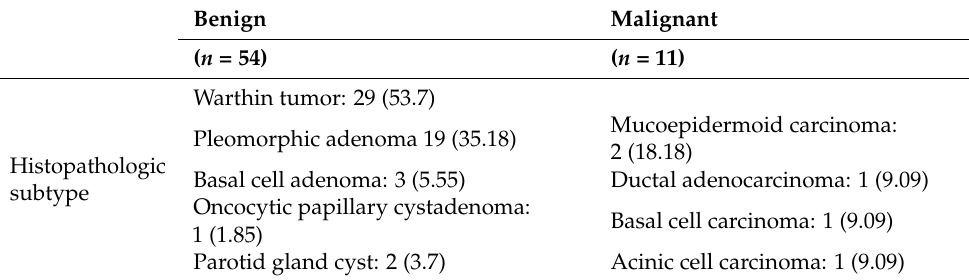
Table 2. Histopathologic subtypes of parotid gland